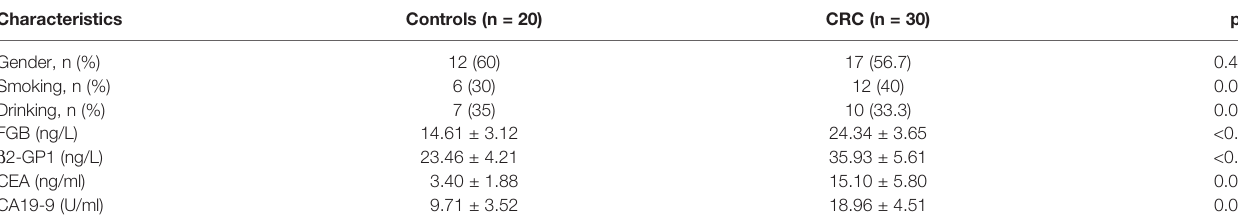
TABLE 1 | Characteristics of subjects (n.s., not signi fi